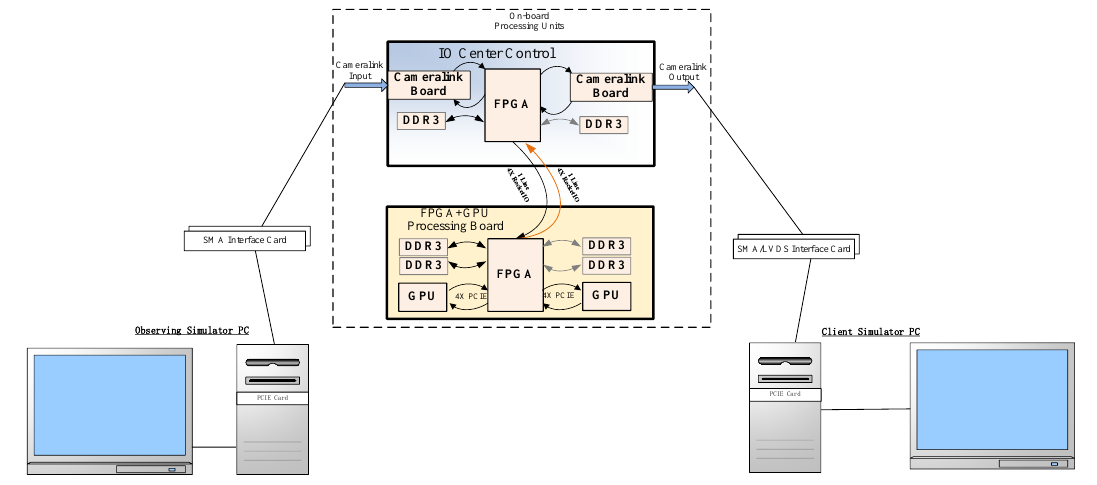
Table 1. Hardware scale of the specific on-board processor (SOBP).